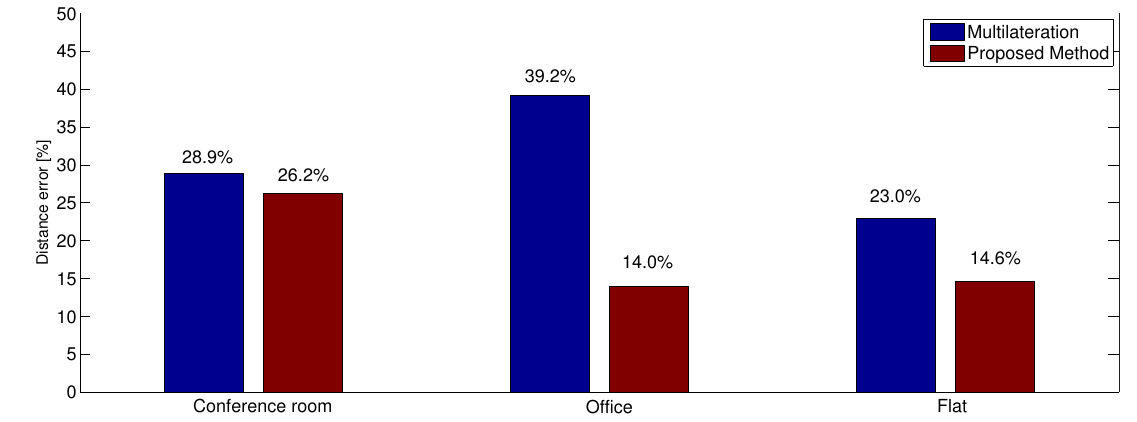
Figure 8. Distance estimation error in percentage using 10